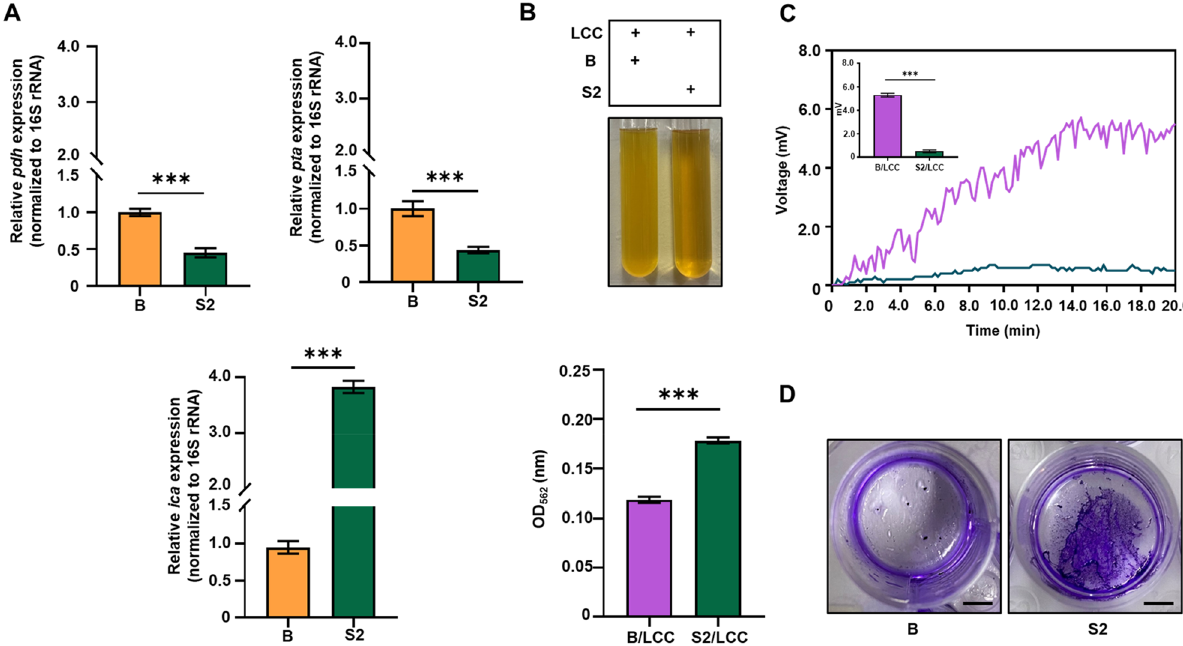
Figure 4. The gene ( pdh , pta , and icaA ) expression, electricity and biofilm formation in S. epidermidis ATCC 12228 and S2 isolate. ( A ) Relative expression of pdh , pta , and icaA genes normalized to 16S rRNA was analyzed by the RT-qPCR. ( B ) LCC fermentation for 12 h in rich media was quantified by measurement of OD 562 . ( C ) Electricity production of bacteria in the presence of 2% LCC was analyzed by voltage changes (mV) in an in vitro chamber. ( D ) Bacterial biofilms were stained by crystal violet after culture of bacteria in TSB on a 24-well plate for 48 h. B/LCC: S. epidermidis ATCC 12228 plus 2% LCC; S2/LCC: S. epidermidis S2 isolate plus 2% LCC. Scale bars = 1 cm. Data are the mean ± SD from three separate experiments. ** P < 0.01; *** P < 0.001 (two-tailed